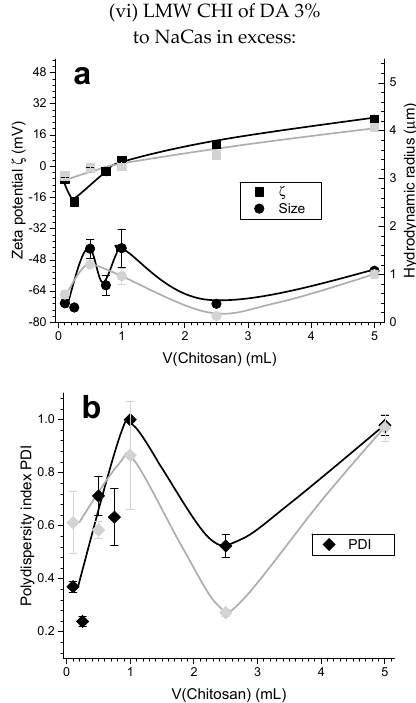
Figure 10. ( a ) Zeta potential ζ , hydrodynamic radius (size), and ( b ) polydispersity index PDI obtained for the experiment (vi) of the Case II (caseinate in excess): LMW CHI of high DA = 13% added to caseinate. Black curves show the characteristics of the chitosan-caseinate PEC colloidal system obtained in the first week; grey curves show the results obtained after two weeks aging at room temperature.